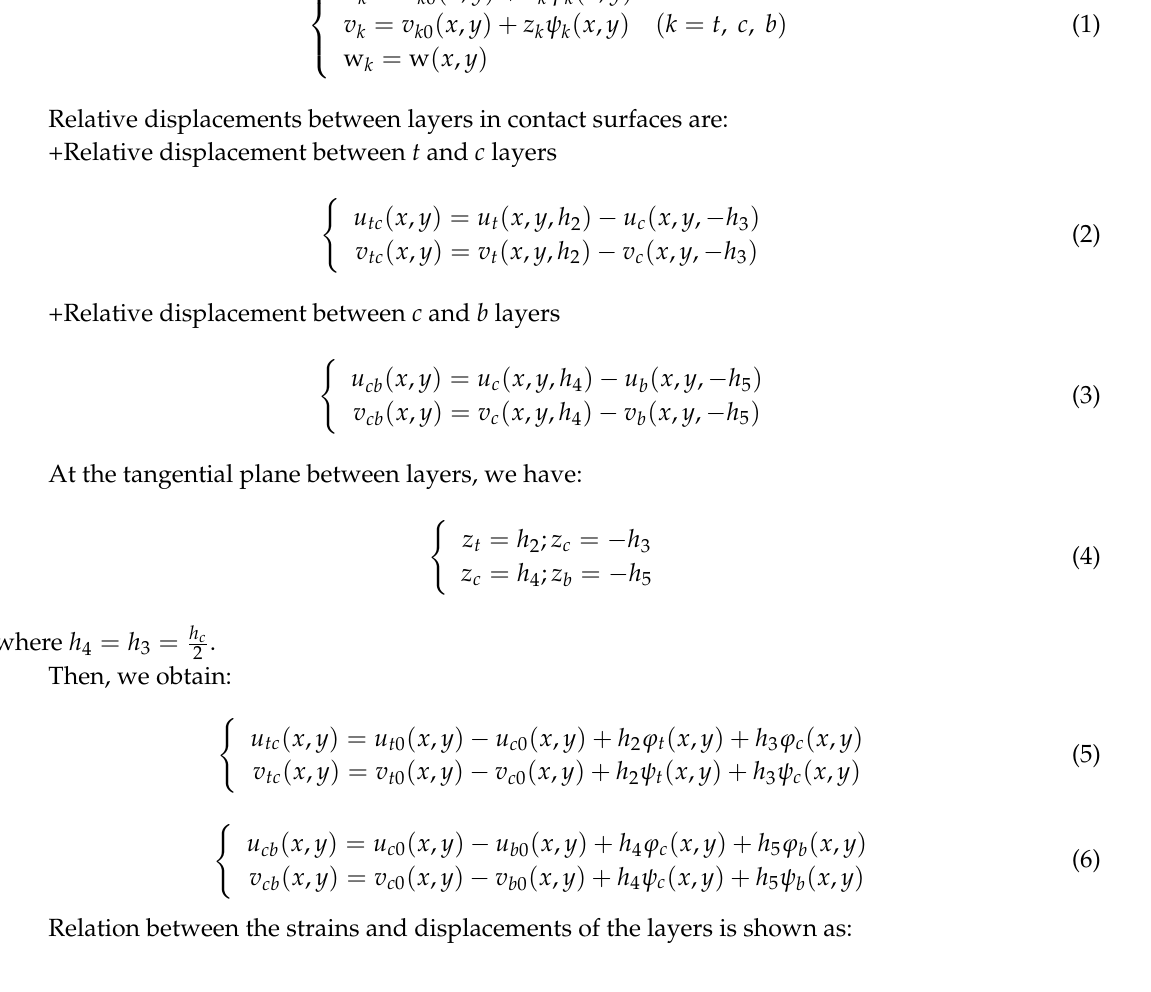
Figure 1. Model of a triple-layer composite plate with a shear connector subjected to a moving load. The plate includes three layers: top layer ( t ), bottom layer ( b ) and intermediate layer ( c ), which can be made of the same or different materials. These layers can slide relative to each other but are not allowed to disconnect during the deformation. Each layer is attached with the local coordinate oxyt , oxyc and oxyb. The plate is divided into six components h 1 , h 2 , h 3 , h 4 , h 5 , h 6 , as in Figure 1. u t 0 , u c 0 and u b 0 are the displacements along the x axis; v t 0 , v c 0 and v b 0 represent the displacements along the y axis at the mid-plane of each layer. u tc , u cb are the relative displacements between ( t ) layer and ( c ) layer along x axis; v tc , v cb are the relative displacements between ( t ) layer and ( c ) layer along y axis